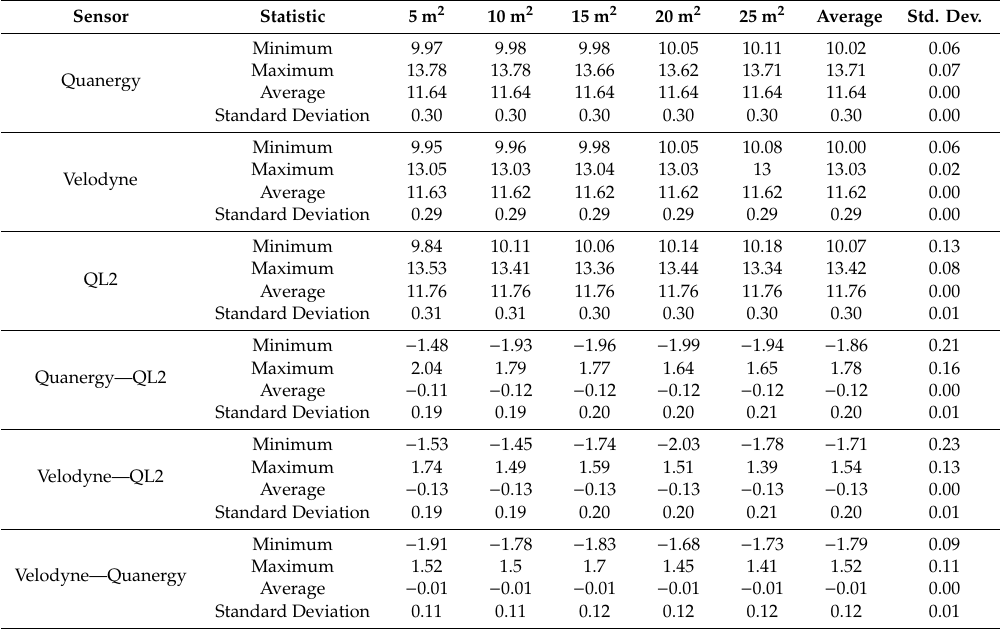
Table 5. Mean elevation (in meters) statistics for each sensor (Quanergy, Velodyne and QL2 LiDAR), tessellation size, and di ff erences between